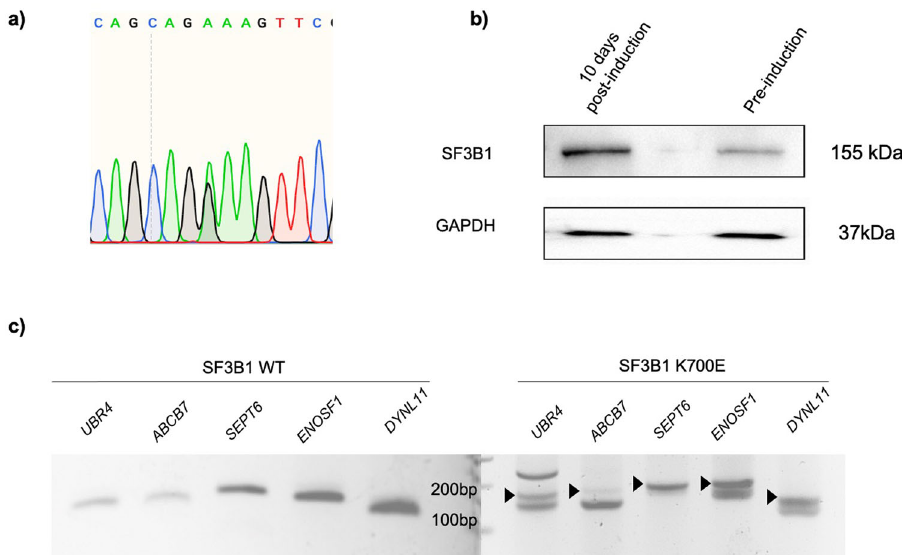
Fig. 4 Validation of human cell lines with single-allele SF3B1 mutant gene. a Sanger sequencing of cDNA from K562 isogenic cell line sample (5 days post-induction) con fi rming mutant SF3B1 mRNA expression. b Western blot-based con fi rmation of expression of the mutant SF3B1 allele. Depicted is the western blot with SF3B1 antibodies on lysates from parental ( SF3B1 wt/null ) clone and cells 10 days post-induction ( SF3B1 wt/K700E ). The induction of mutant SF3B1 allele leading to expression of mutant SF3B1 protein (same size as the wild-type SF3B1 protein) doubles the SF3B1 protein expression as compared to the pre-induced sample. c Validation of cryptic 3 ’ splice site usage in fi ve selected genes frequently mis-spliced in SF3B1 mutant myelodysplastic syndrome. PCR products of the fi ve genes ( UBR4 , ABCB7 , SEPT6 , ENOSF1 , DYNL11 ) showing aberrant cryptic 3 ’ SS usage in the K562 SF3B1 mutant (cryptic transcripts indicated by black arrow